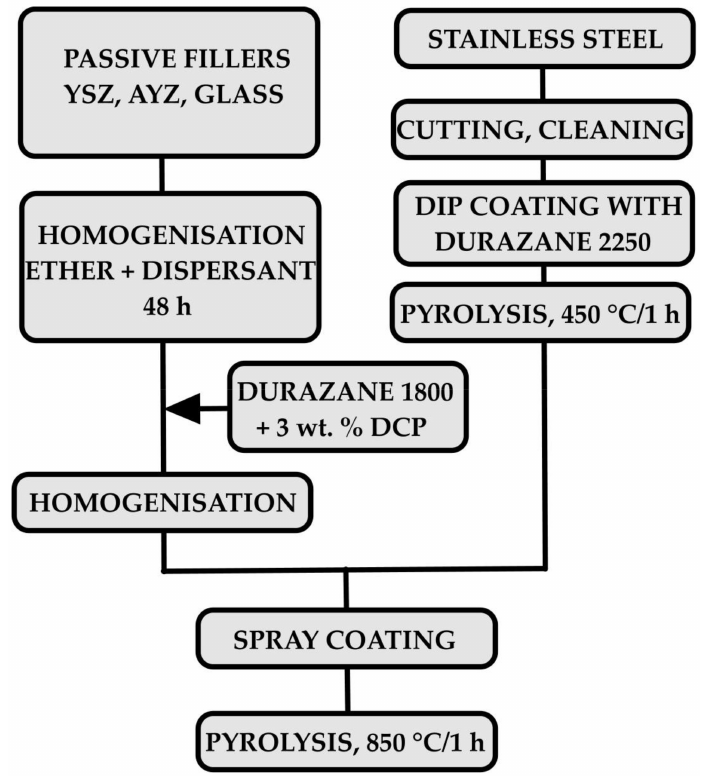
Figure 2. The flowchart of the coatings preparation